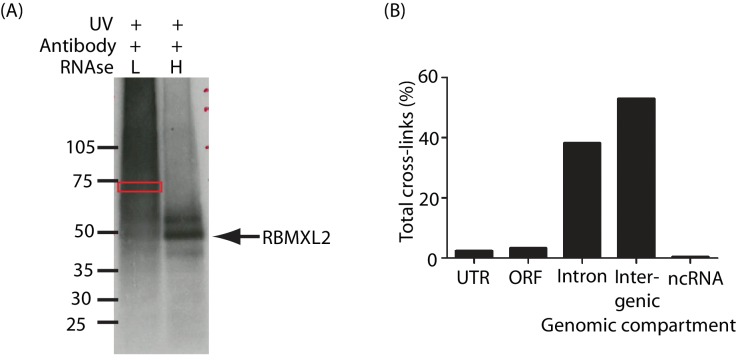
HITS-CLIP analysis of RBMXL2 in the adult mouse testis.(A) Autoradiograph showing SDS-PAGE gel of 32P-labelled RNA crosslinked to endogenous RBMXL2 protein from mouse testis during a HITS-CLIP experiment. The area indicated by the red box was excised for further analysis. (B) Genome wide distribution of RBMXL2 HITS-CLIP tags.